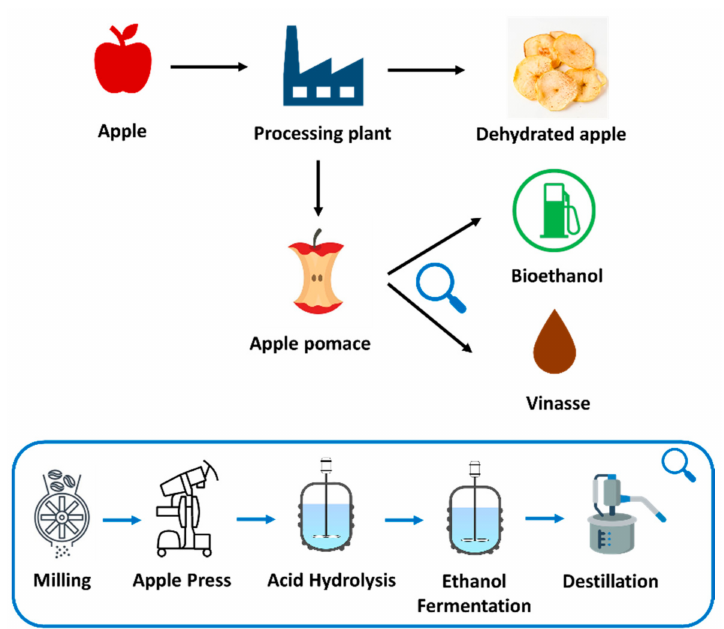
Figure 1. Apple pomace ethanol and vinasse production